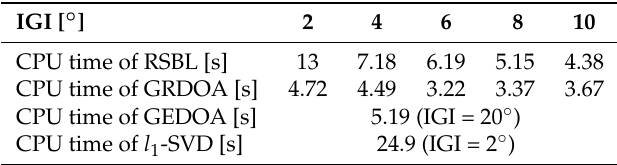
Table 2. Time Comparison versus the Initial Grid Interval